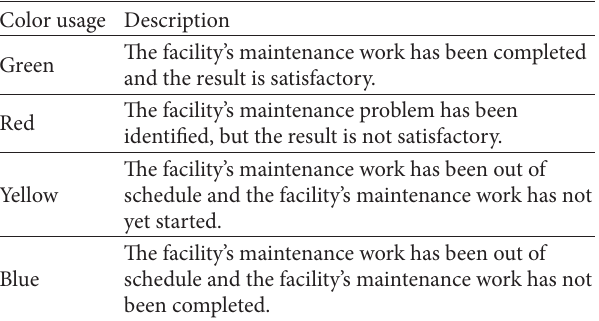
Table 1: Description of color usage in BIM